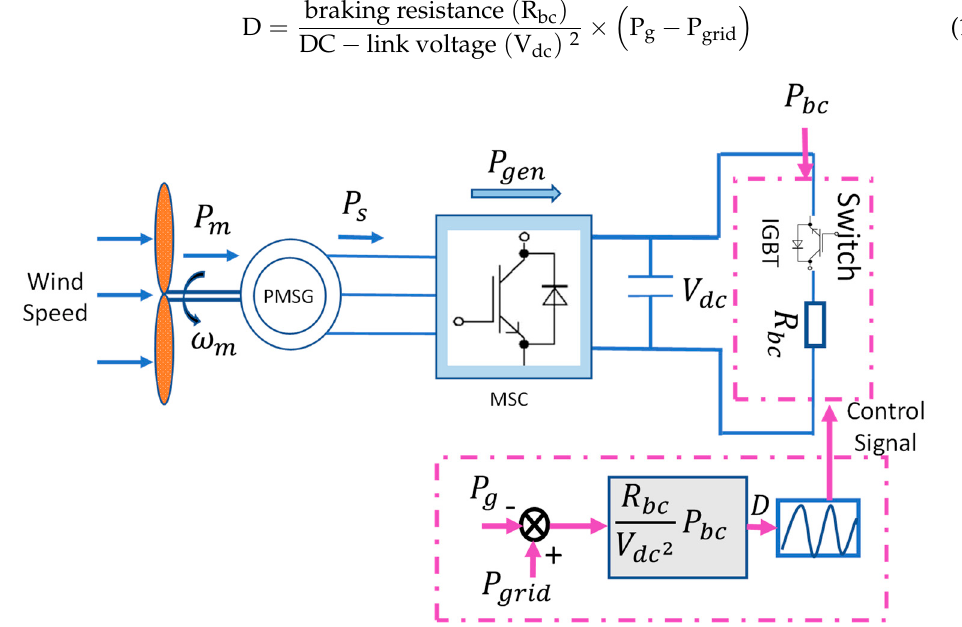
Figure 16. System control block diagram.